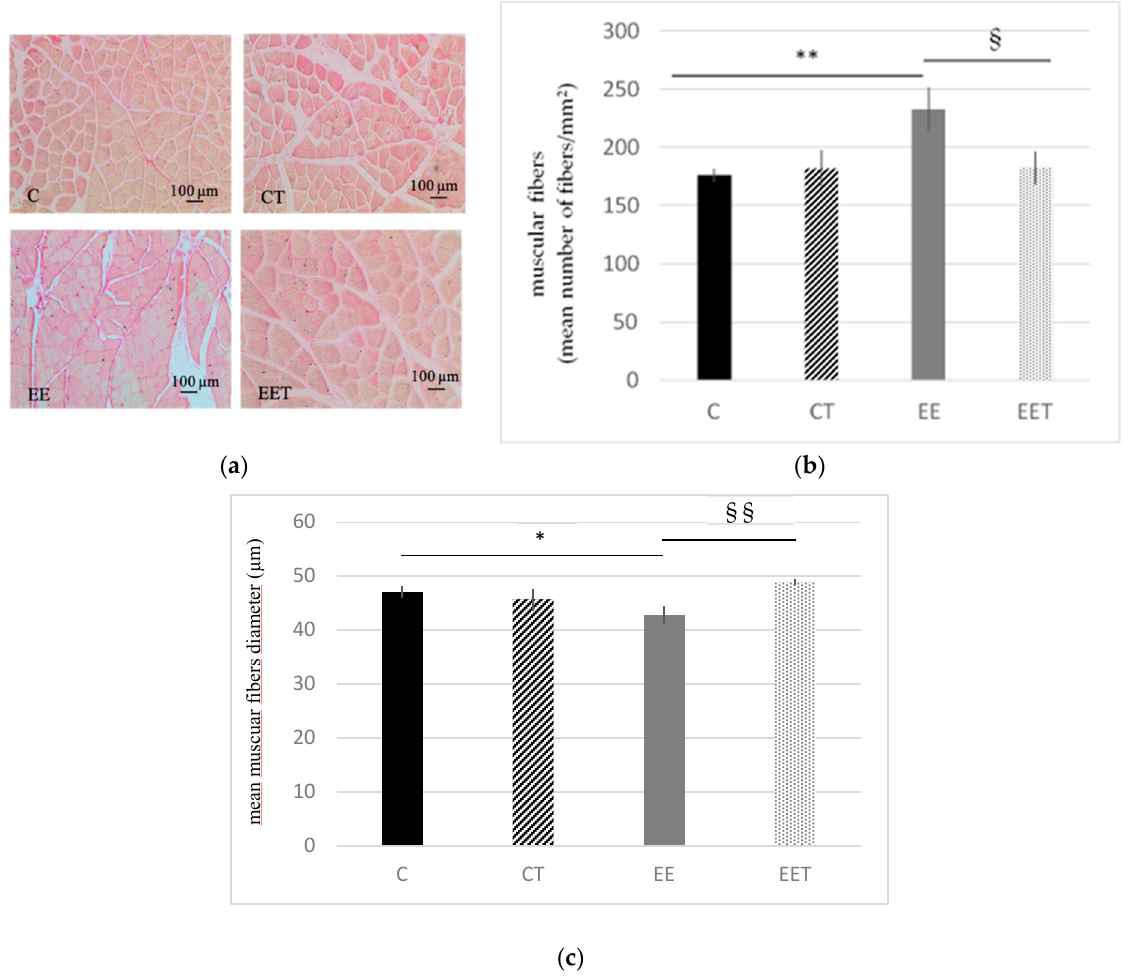
Figure 2. Influence of melon concentrate supplementation on the number and diameter of muscular fibers (gastrocnemius muscle). ( a ) Hematoxylin ‐ Eosin Staining (HES) histochemical staining of muscular fibers. ( b ) muscular fibers were quantified on five transverse sections per muscle. Results are expressed in number of fibers/mm2 of muscle ± SEM. ** p < 0.01 effect of the eccentric exercise compared with control group, § < 0.05 effect of melon concentrate supplement compared with the EE group. ( c ) muscular fibers diameter was measured on five transverse sections per muscle ± SEM. Results are expressed in μ m. * p < 0.05 effect of the eccentric exercise compared with control group, §§ < 0.01 effect of melon concentrate supplement compared with the EE group.